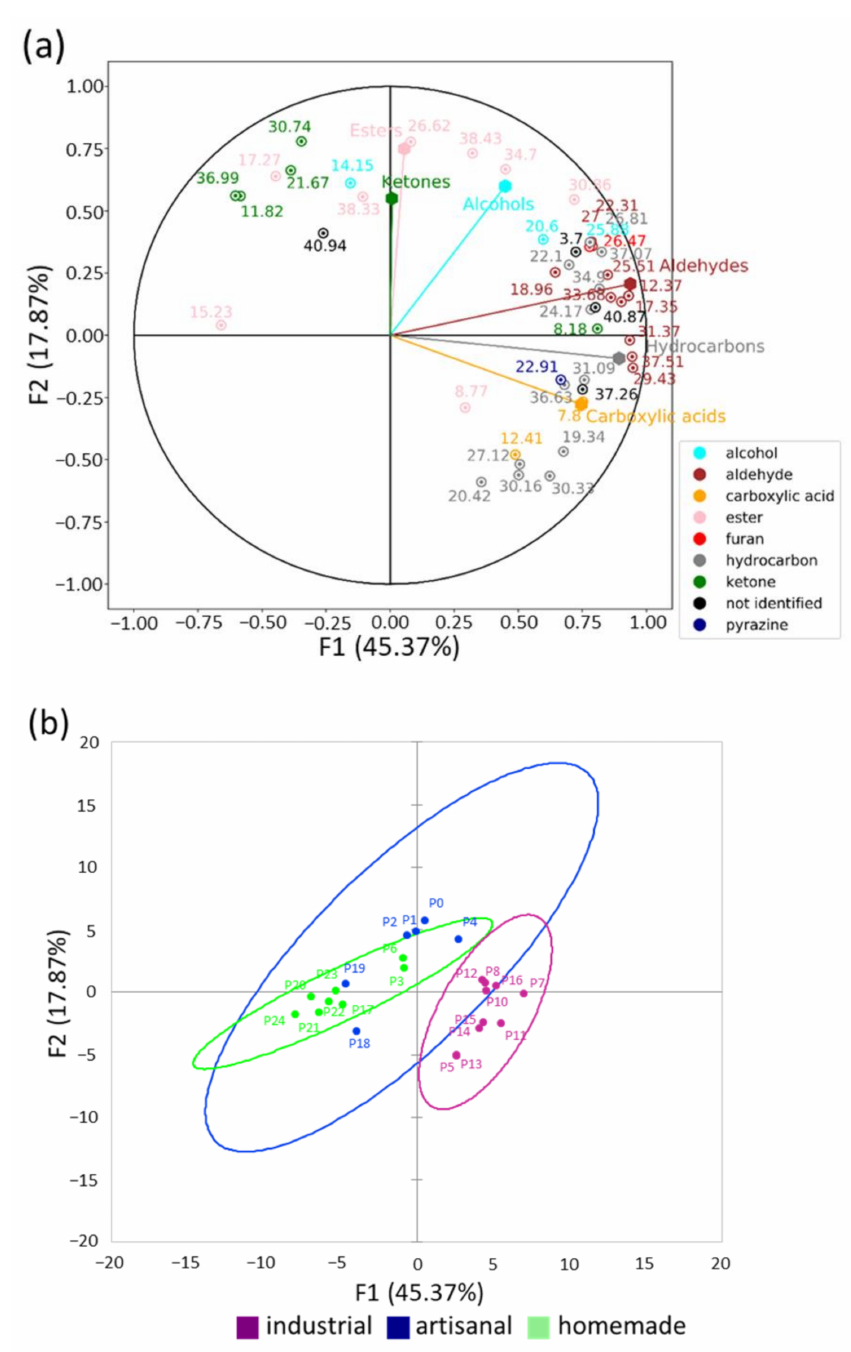
Figure 3. Representation of the correlations among the different volatile molecules in the 24 soft breads through a Principal Component Analysis (F1 + F2 = 63.24%) of areas under the curve. ( a ) Representation of 46 volatile molecules, separated into chemical families and labeled accord- ing to their mean retention time in Table 4; ( b ) biplot of the 24 soft breads, displayed by processing method, with 95% confidence